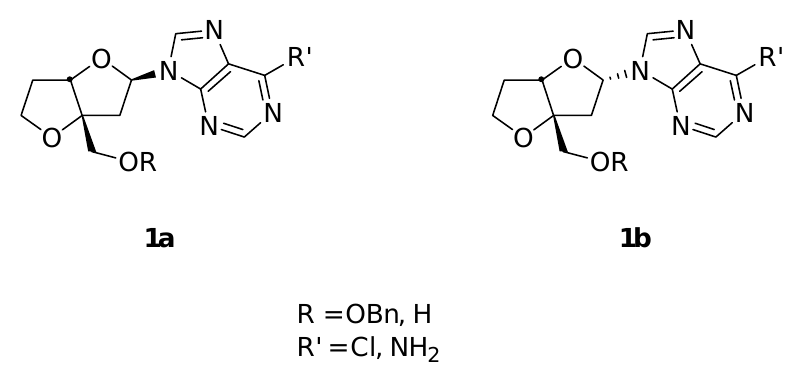
Figure 2. Target Bicyclic Derivatives.